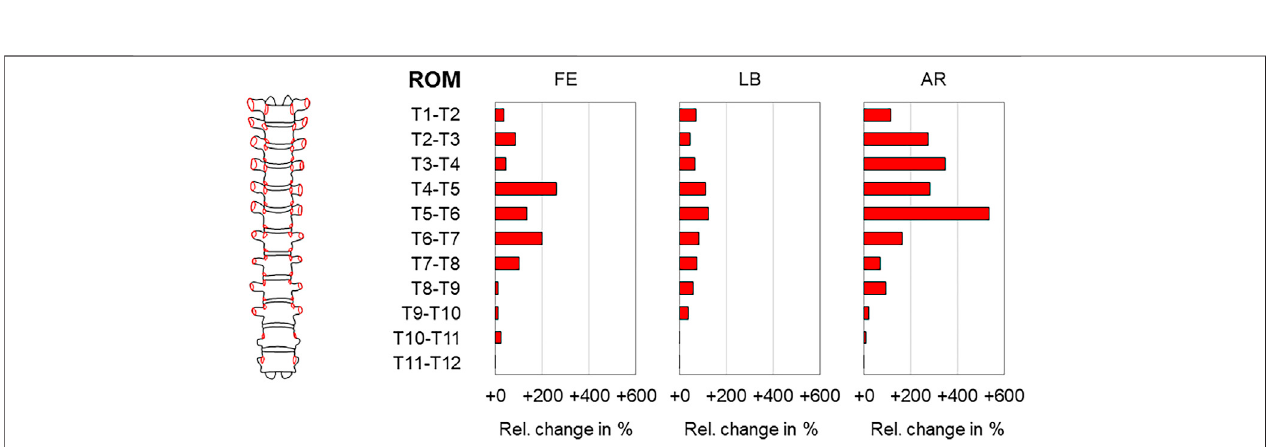
FIGURE 13 | Complete rib cage removal. The relative range of motion (ROM) changes of the thoracic spine (T1 – T2, T2 – T3, ... , T11 – T12) during fl exion/extension (FE), lateral bending (LB), and axial rotation (AR) after complete rib cage removal according to Liebsch et al. (2017a).